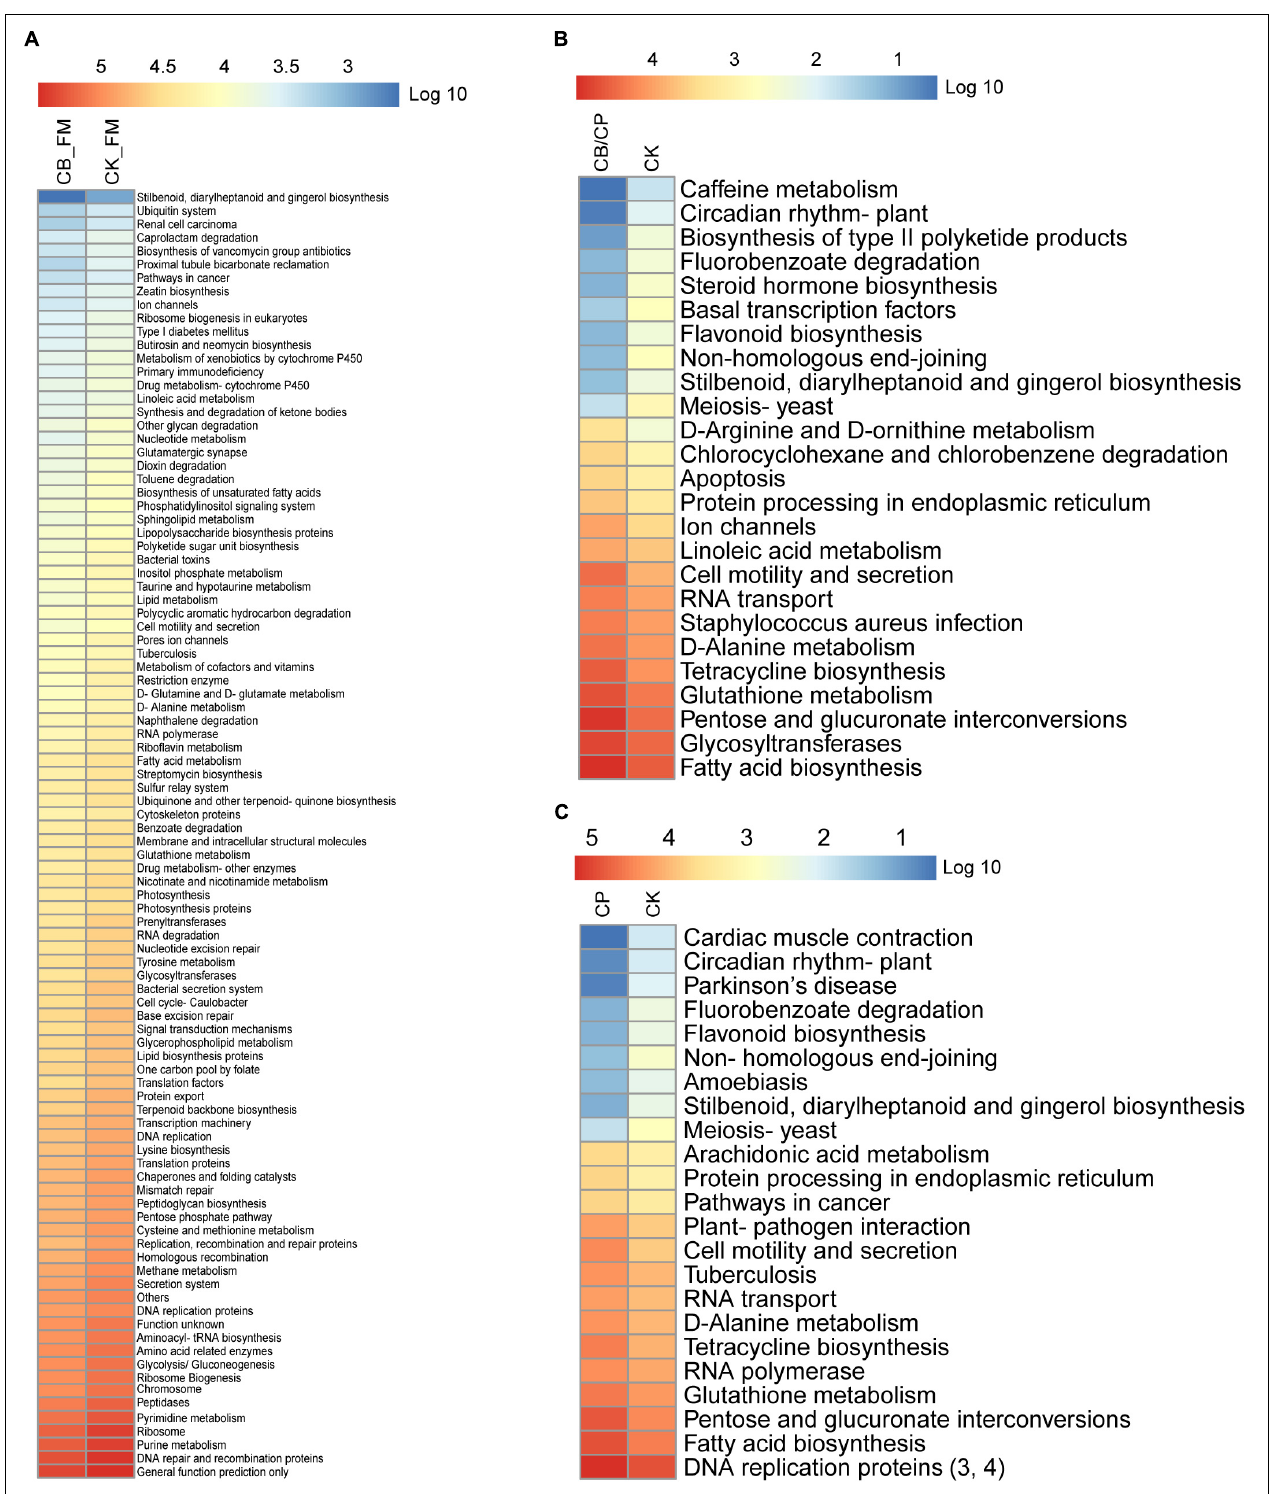
FIGURE 7 | Heatmap of predicted KEGG pathways of the gut bacteria in each group. The gene copy numbers of each group are shown as mean values. The significant differences between two groups at different stages were measured using the Mann-Whitney U test with a cutoff of p < 0.05 and FDR < 0.1. No significant difference was found between the CB_B and CK_B groups, the CB/CP and CP groups, and the CB and CK groups. Comparisons between the CB/CP and CB groups and the CB and CP groups were not performed. CB_B, CK_B, CB_FM, and CK_FM: n = 12; CB/CP, CB, CP, and CK: n = 6. Comparisons between CB_FM and CK_FM groups, CB/CP and CK groups and CP and CK groups are presented in panel (A) , (B) , and (C) respectively.